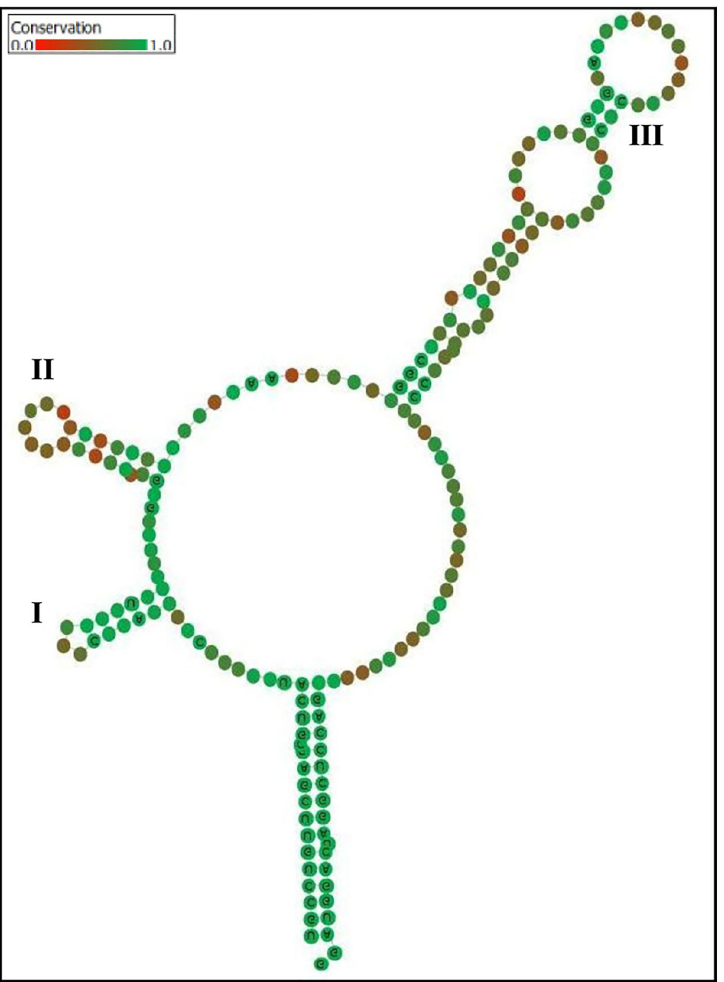
Fig 6. Consensus secondary structure of all internal transcribed spacer 2 (ITS2) sequences employed in molecular morphometric analysis. Helices were numbered I–III from 5’ to 3’ direction. Sequence conservation was indicated with colours from red (not conserved) to green ( > 51%;